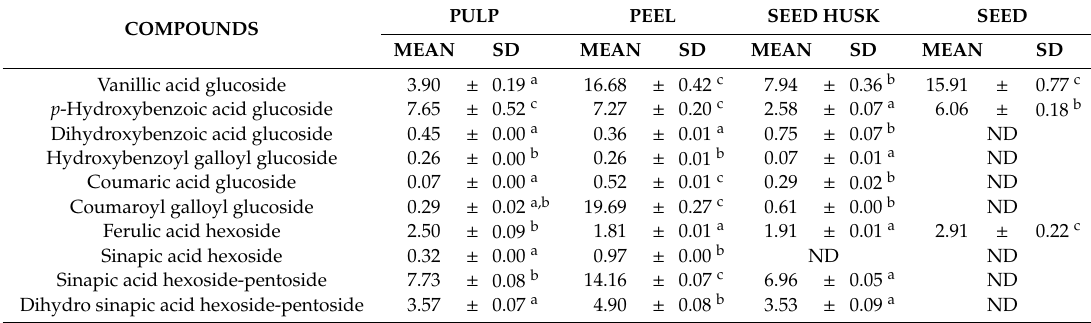
Table 2. Mean concentration of gallic acid derivative compounds from di ff erent parts of Keitt mango variety at optimum maturation stage expressed as mg / 100 g dry matter .